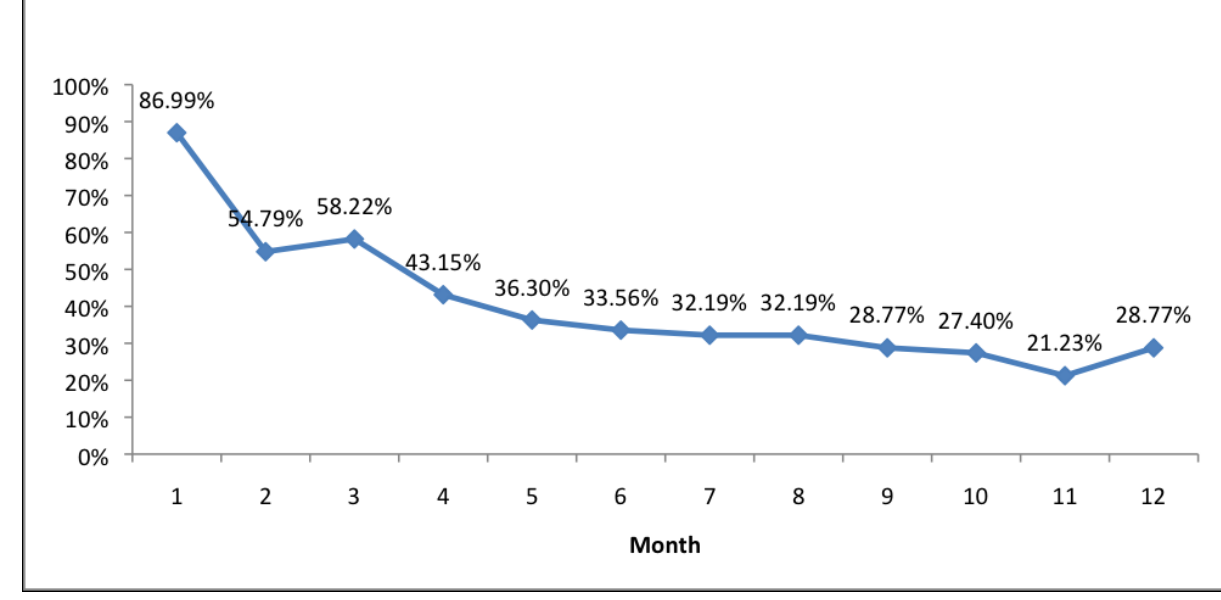
Figure 5. Percentage of active Comprehensive Health Enhancement Support System (CHESS) users by